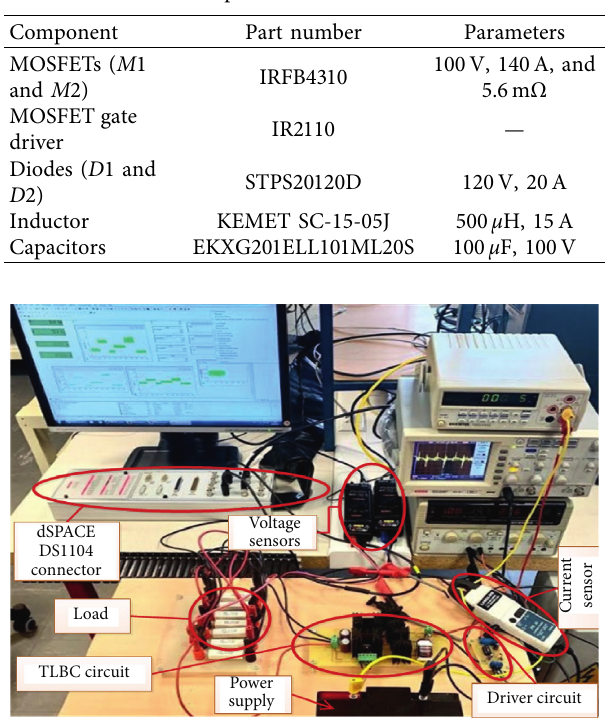
Figure 5: The experimental test bench.